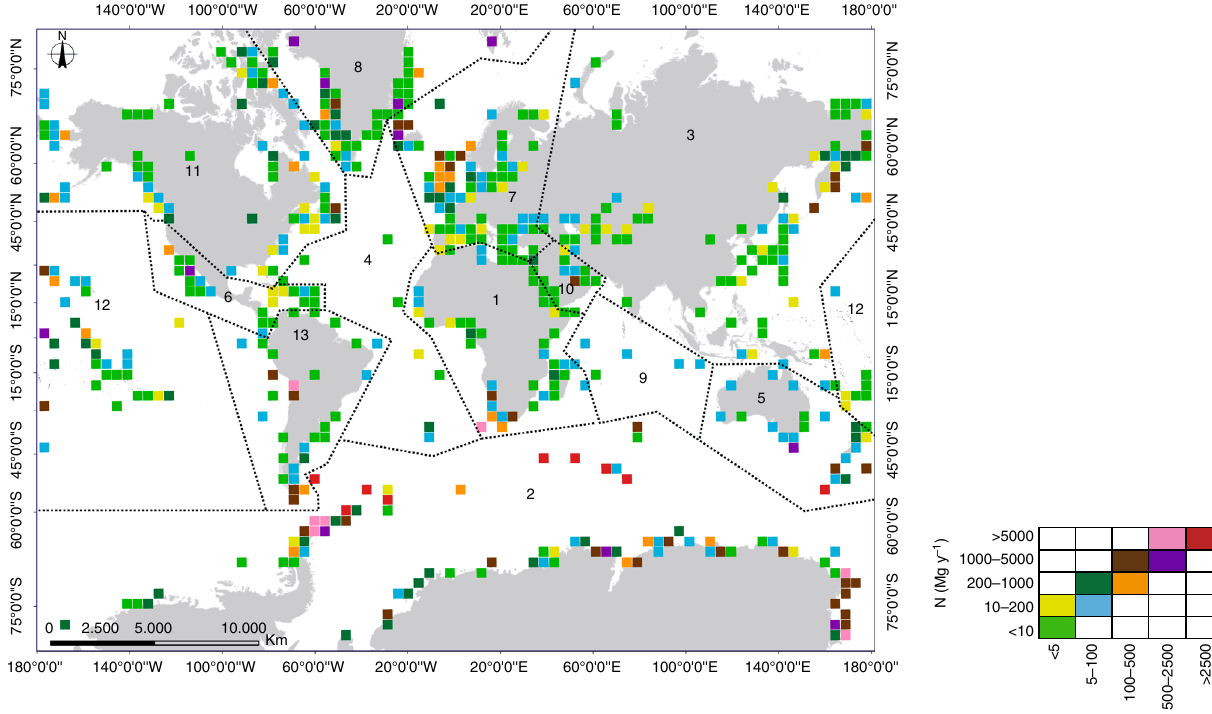
Fig. 2 Global distribution of N and P excretion by seabird colonies. To show the colony distributions in a clear way, a fi shnet grid of square cells with 500 km sides and the sum of the number of seabirds included in each cell was generated. Lines delineate regional boundaries after Riddick et al. 18 : 1. Africa, 2. Antarctica and Southern Ocean, 3. Asia, 4. Atlantic, 5. Australasia, 6. Caribbean and Central America, 7. Europe, 8. Greenland and Svalbard, 9. Indian Ocean, 10. Middle East, 11. North America, 12. Paci fi c and 13. South America. Scale shows fl uxes in Mg y − 1 , where 1 Mg = 1 × 10 6 g